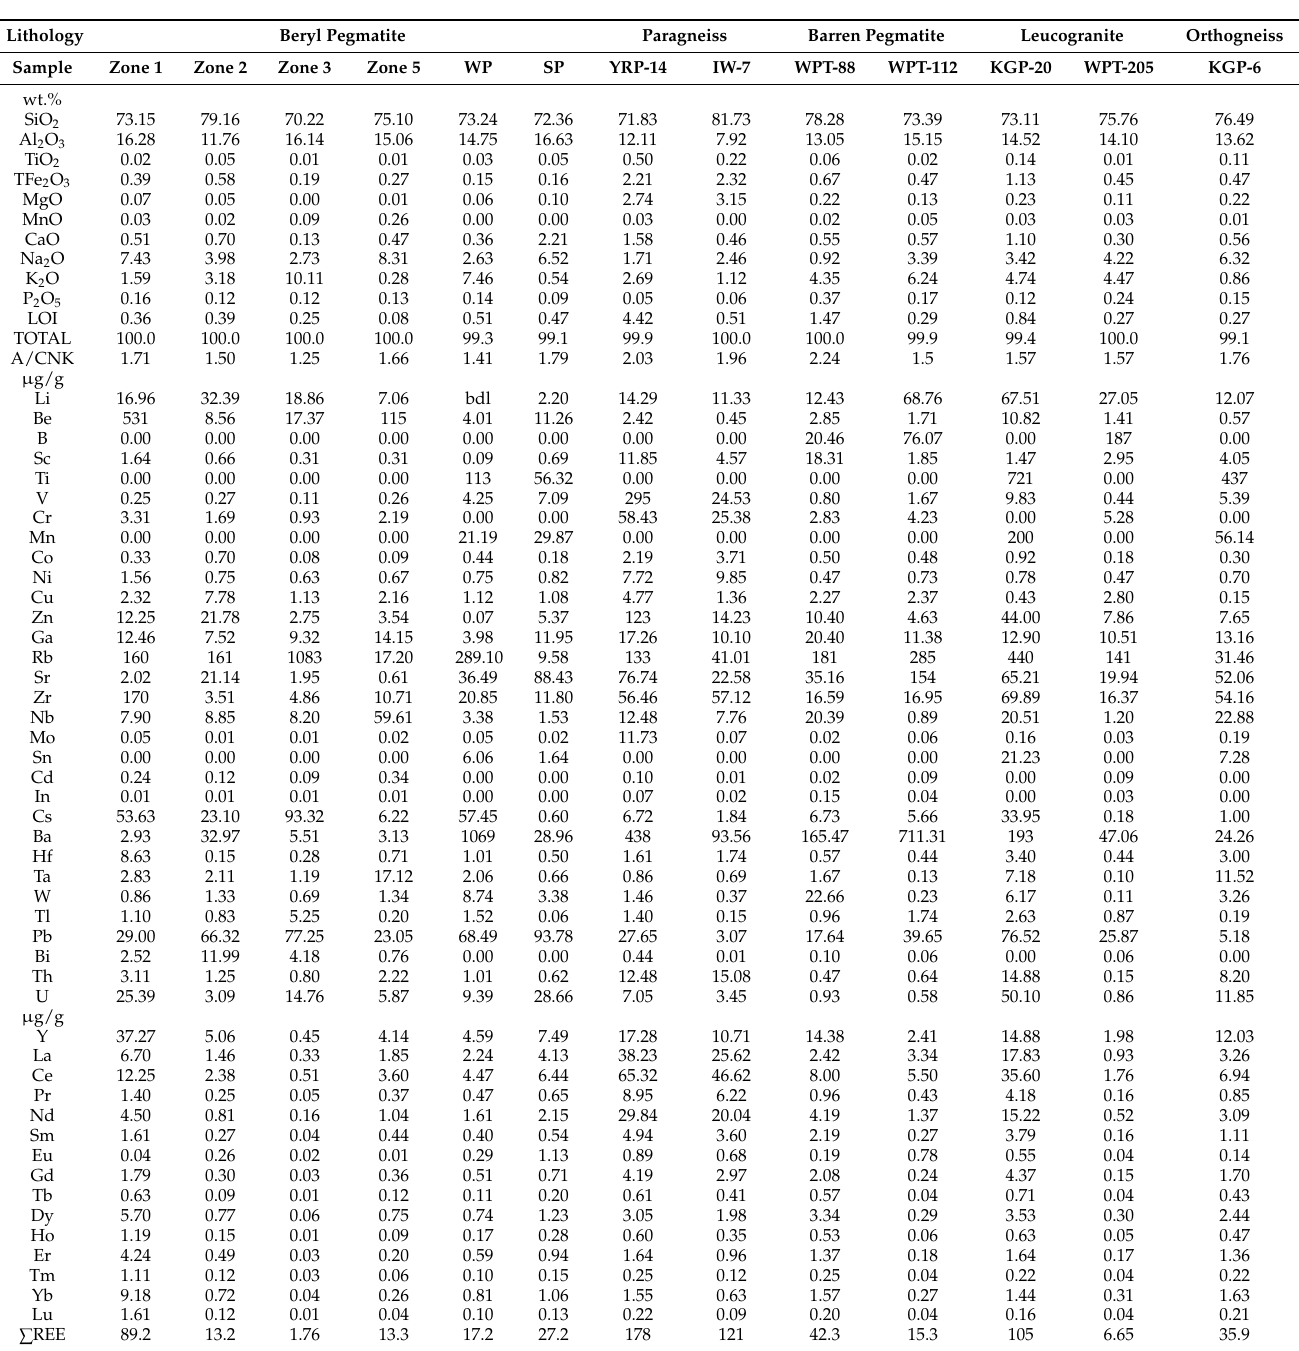
Table 2. Whole-rock major and trace element composition of selected pegmatite, gneiss and gran- ite